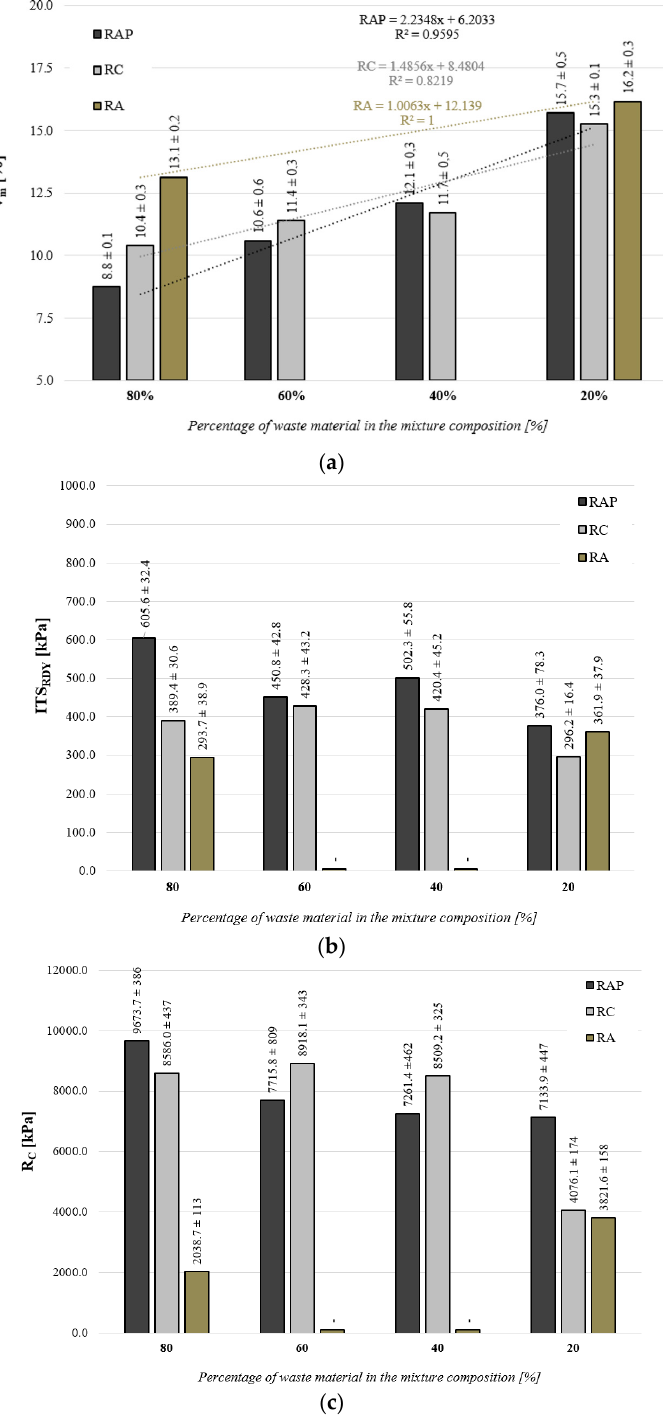
Figure 6. Comparison of test results for: ( a ) air void content (Vm), ( b ) indirect tensile strength (ITSDRY), ( c ) axial compression strength (RC), confidence interval of